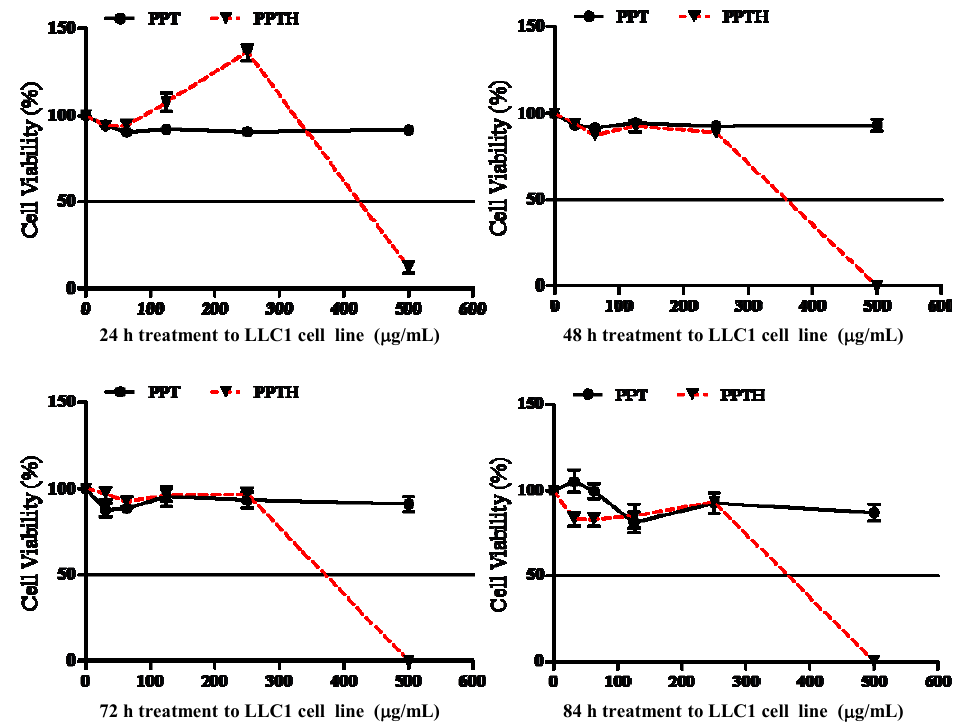
Figure 5. Time- and dose-dependent cytotoxicity of PPT and PPTH on LLC1